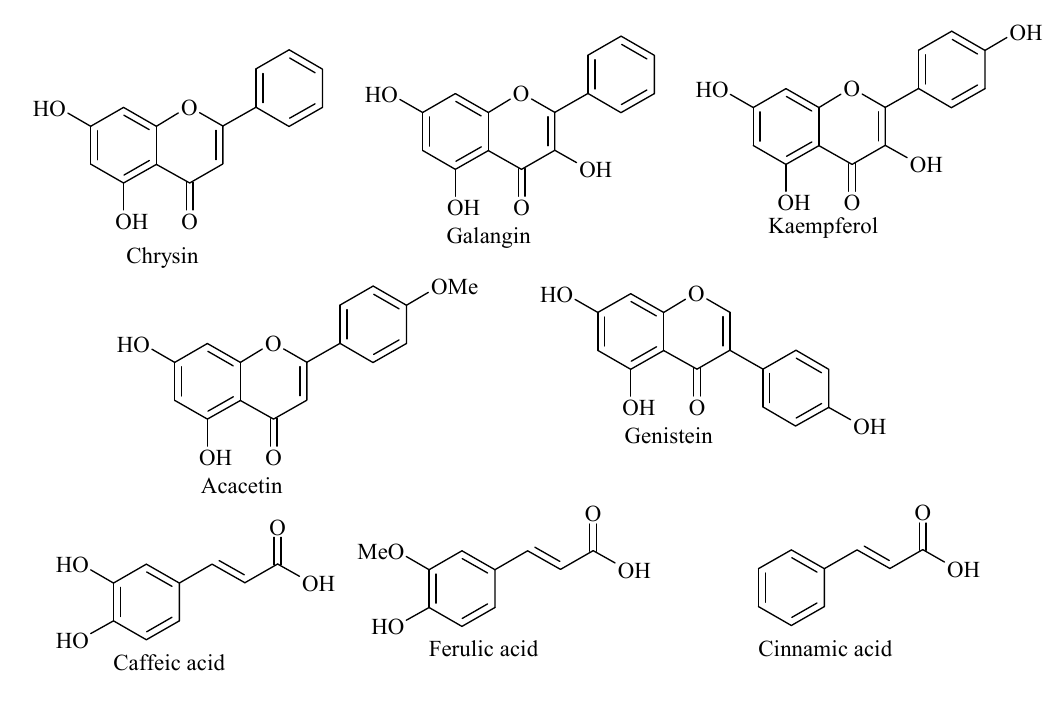
Figure 5. Structures of the tested compounds on